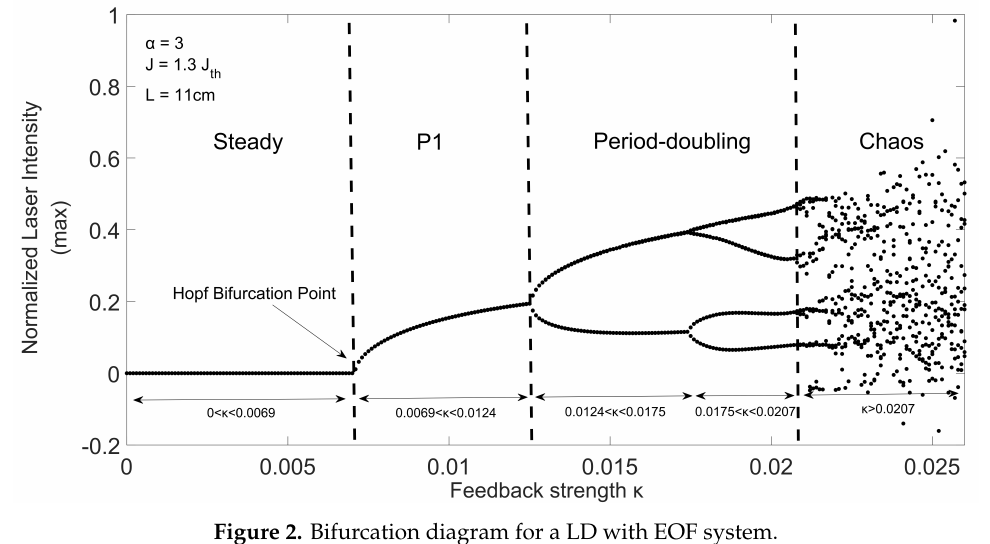
Figure 2. Bifurcation diagram for a LD with EOF system.